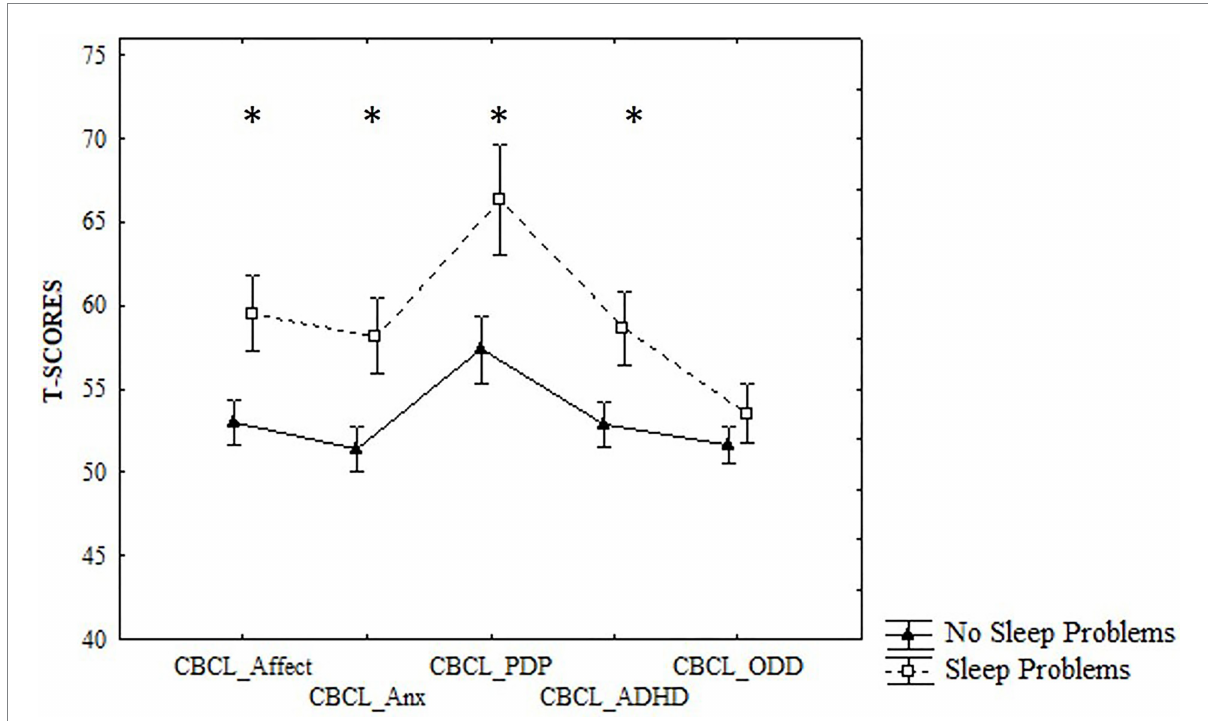
FIGURE 1 Differences between No Sleep Problems and Sleep Problems groups in CBCL DSM-IV scales scores. * p <